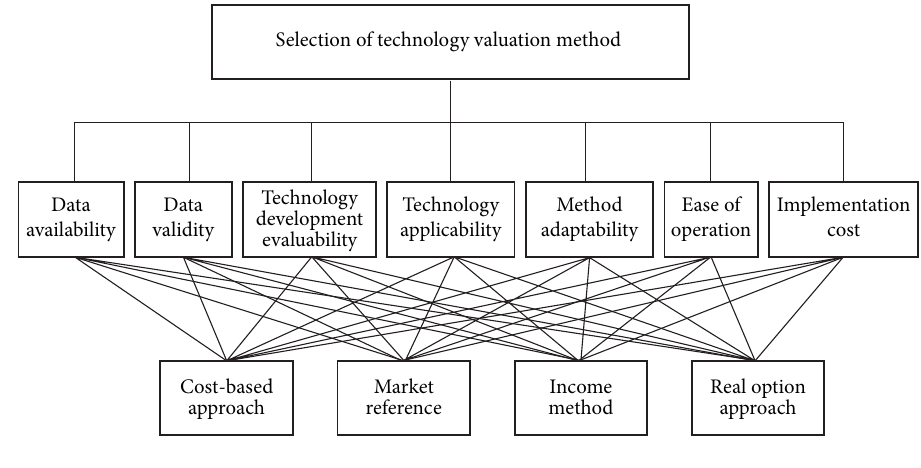
Fig. 2. The fuzzy AHP